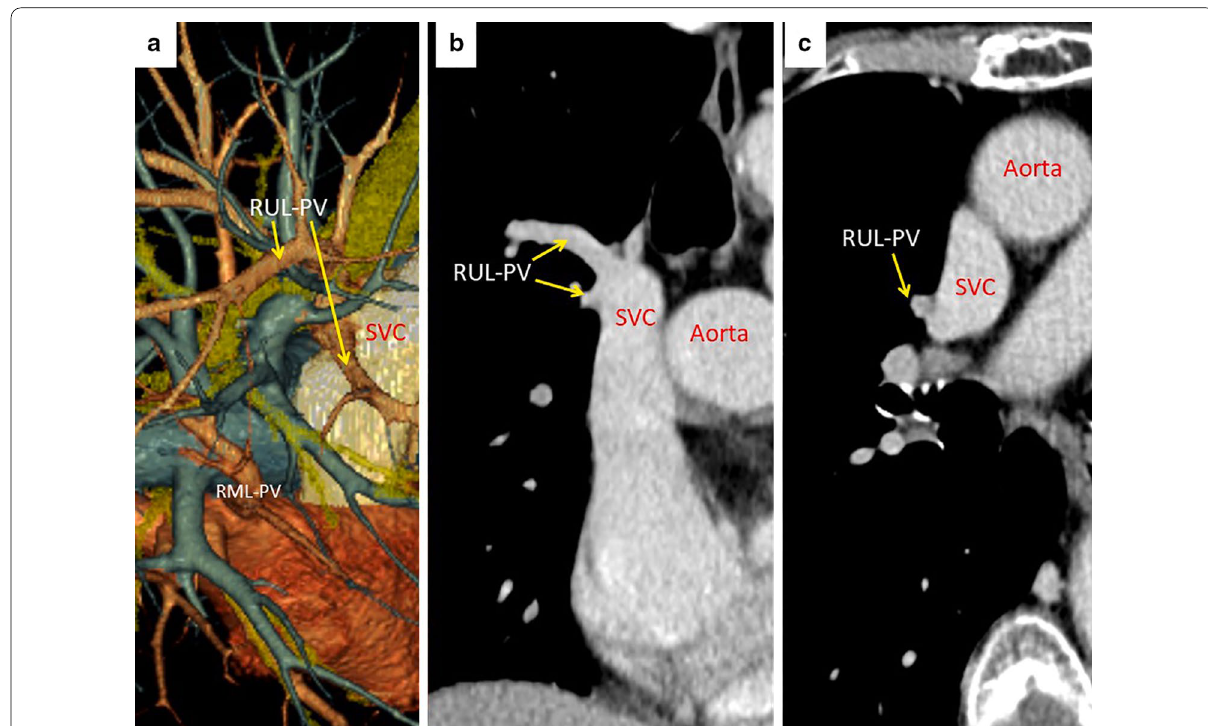
Fig. 2 Three-dimensional computed tomography (CT) angiography ( a ) and enhanced CT ( b : coronal view, c : axial view) revealed the partial anomalous pulmonary venous connection in the right-upper lobe returning into the superior vena cava (SVC). RUL right-upper lobe, RML right-middle lobe, PV pulmonary